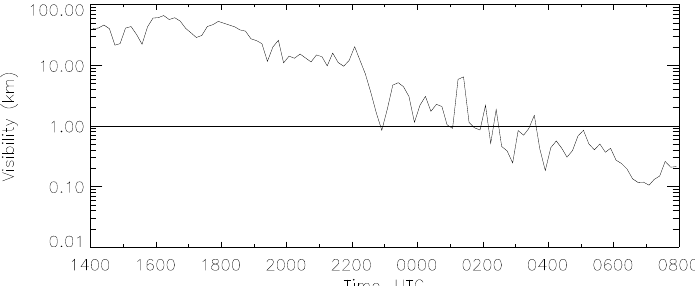
Atmosphere 2020 , 11 , x FOR PEER REVIEW Figure 3. Visibility at Skyborry during the period 18–19 September 2015. Figure 3. Visibility at Skyborry during the period 18–19 September 2015. Figure 3. Visibility at Skyborry during the period 18–19 September 2015.